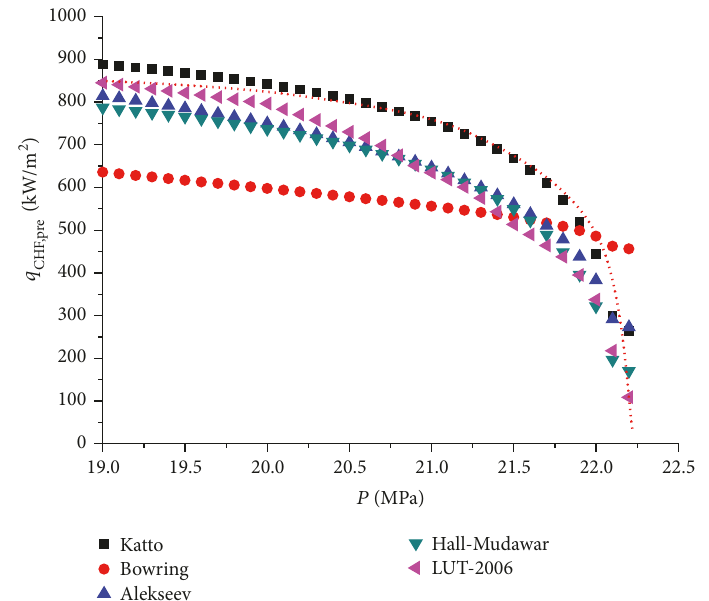
Figure 2: q 𝐶𝐻𝐹 as a function of pressure ( G =2000 kg/m 2 s, △ℎ 𝑖𝑛 =450 kJ/kg, D =0.013m, L